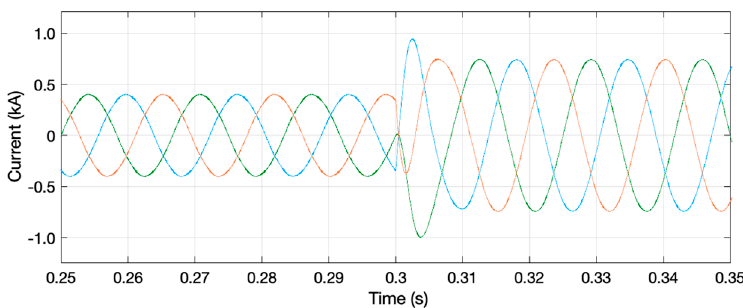
Figure 29. The total output current of the MVDC system for the two operating conditions.